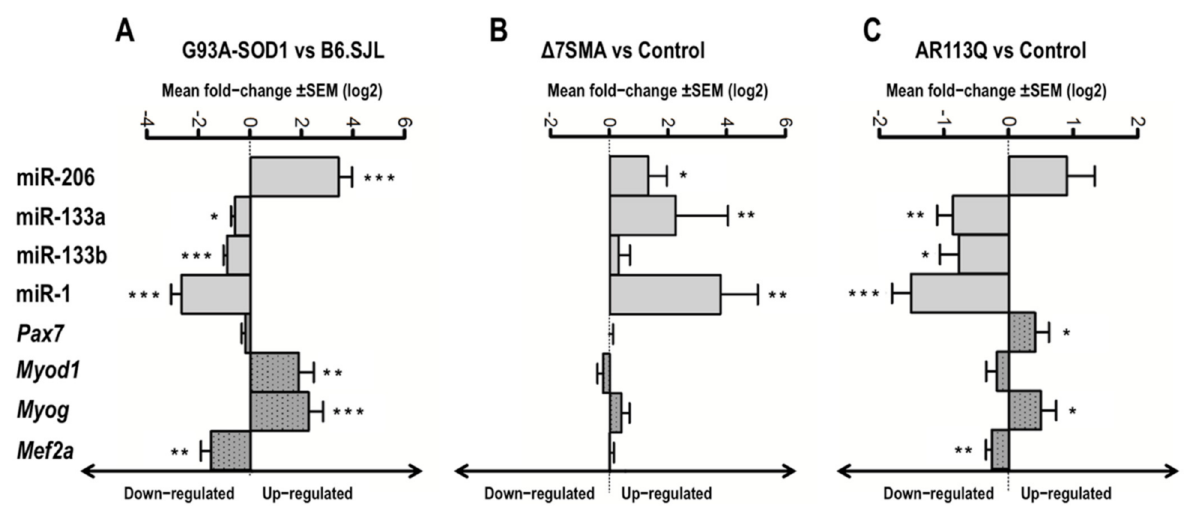
Figure 4. Altered expression of myomiRs and their predicted targets in G93A-SOD1, ∆ 7SMA, and AR113Q mouse muscle. Data are presented as mean ± SEM of log2 of fold changes of 2 − ∆ Ct expression of myomiRs (grey bars) and mRNA targets (grey with dot bars) obtained at different disease stages in ( A ) G93A-SOD1, ( B ) ∆ 7SMA, and ( C ) AR113Q relative to control mice. * p < 0.05, ** p < 0.01, *** p < 0.001, Mann–Whitney